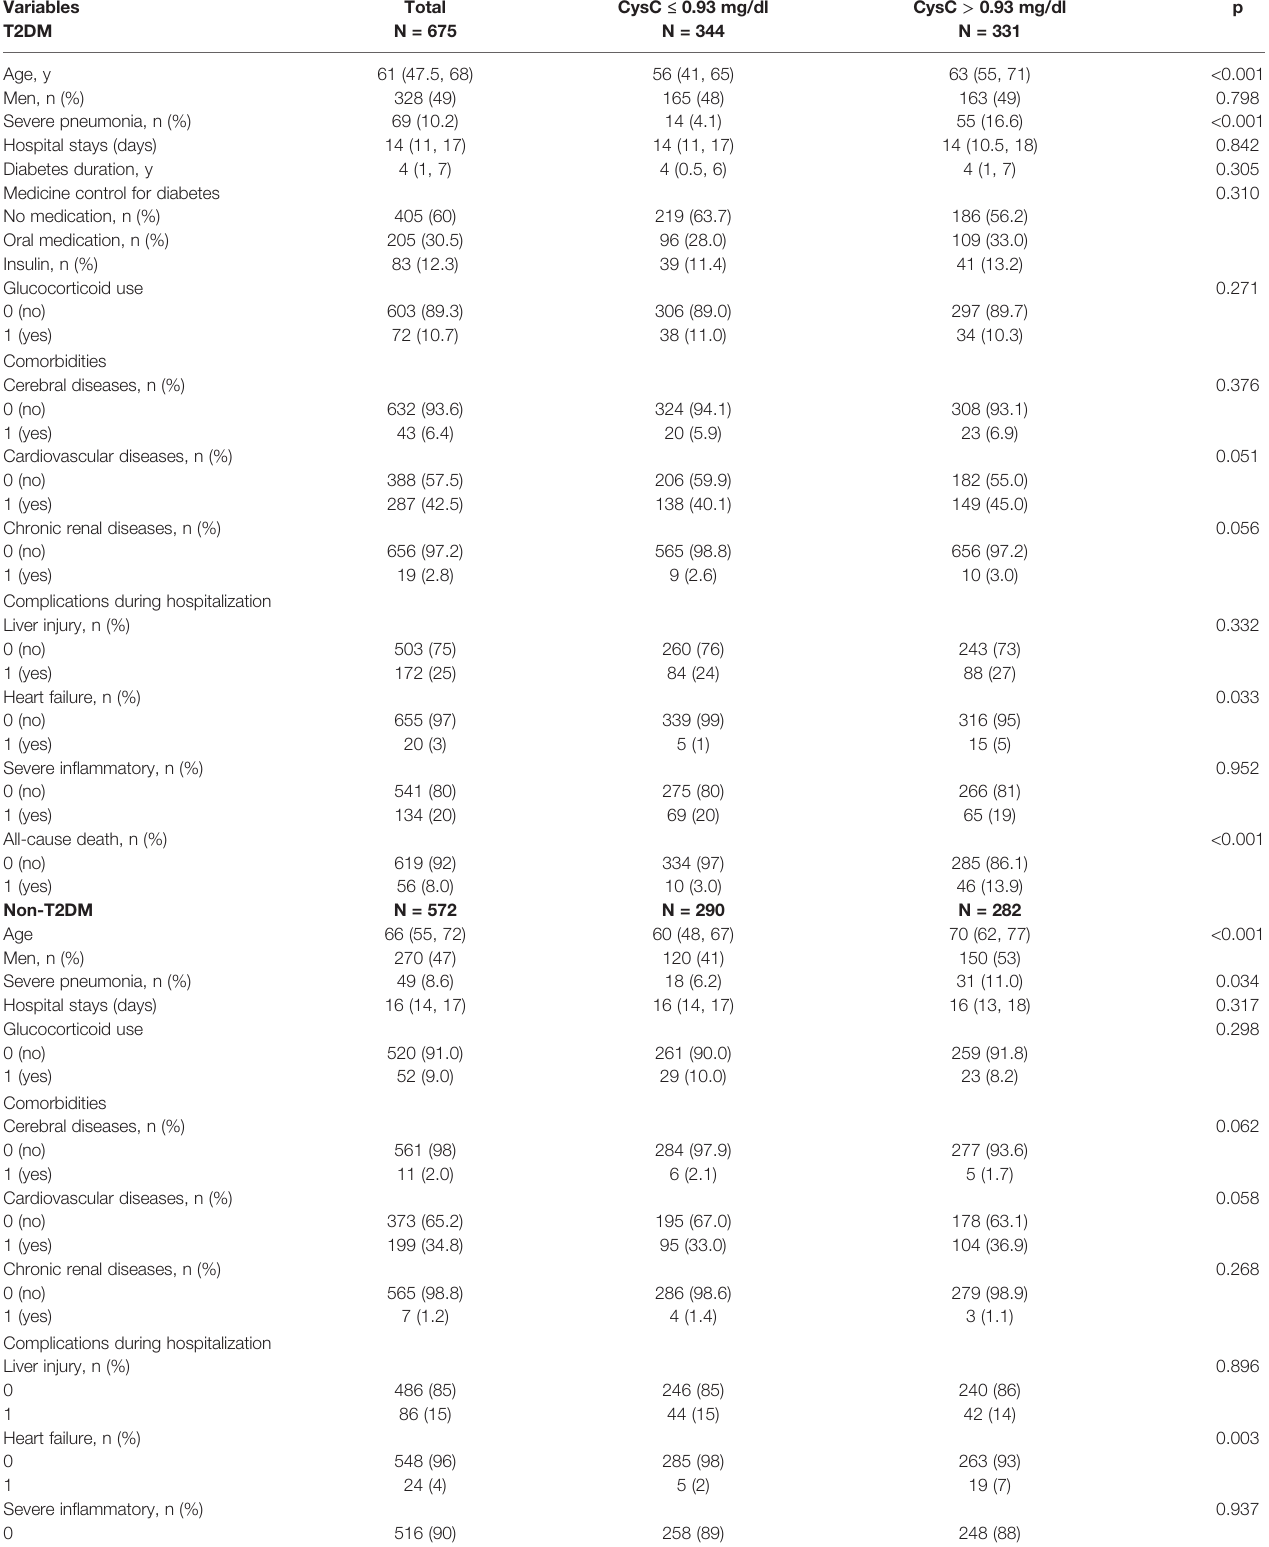
TABLE 2 | Characteristics of T2DM patients and non-T2DM patients according to the CysC